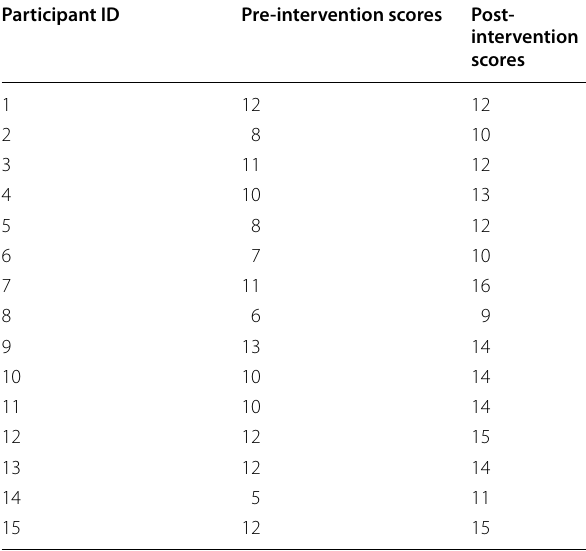
Table 1 Table showing referrers scores at Mengo Hospital Participant